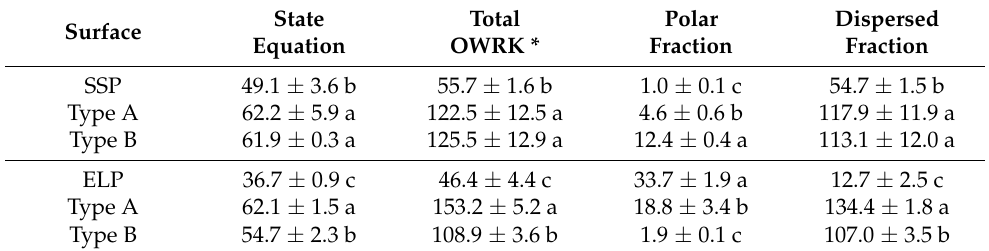
Table 4. Surface free energy (mN/m) of SSP and ELP plates, with and without type A or B deposits. State Total Polar Surface Equation OWRK * Fraction